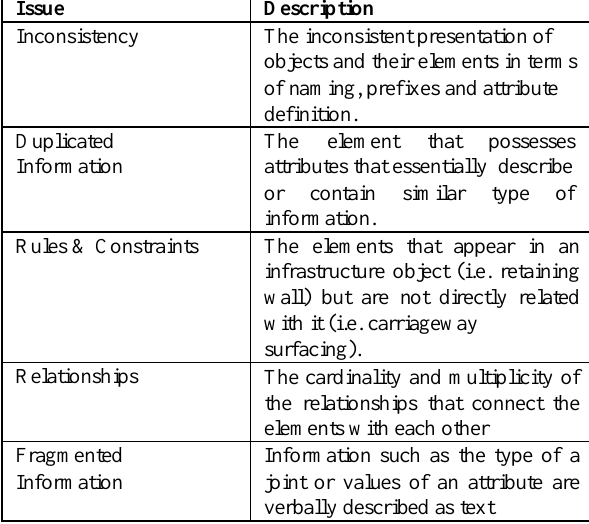
Table 1: Categories of data integrity issues in ADMM